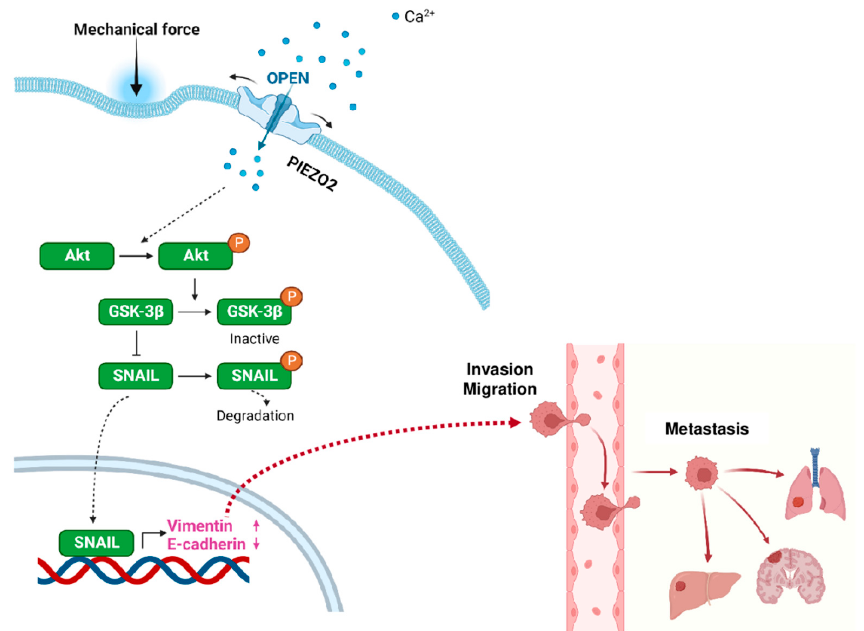
Figure 7. Proposed model for PIEZO2 and its role in metastatic phenotype of triple-negative breast cancer.